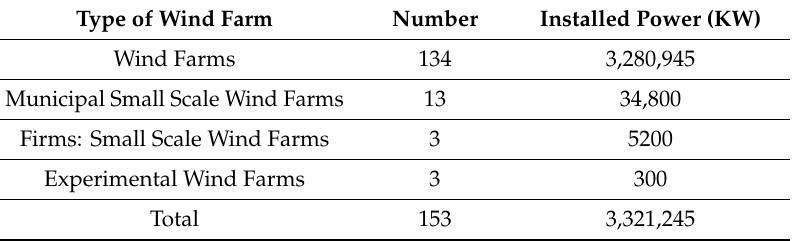
Table 3. Types of wind farms installed in Galicia (1995 – 2017) elaborated from [63].